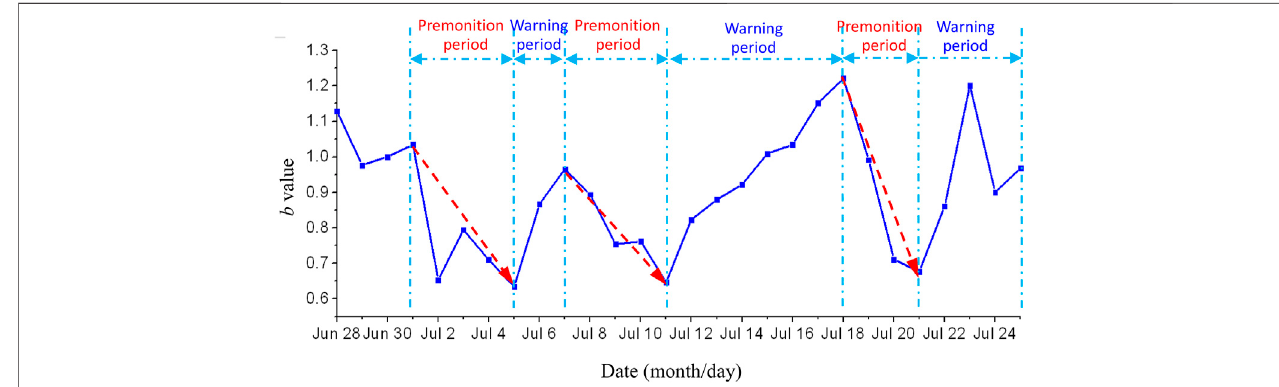
FIGURE 15 | The b value varied with time in diversion tunnel